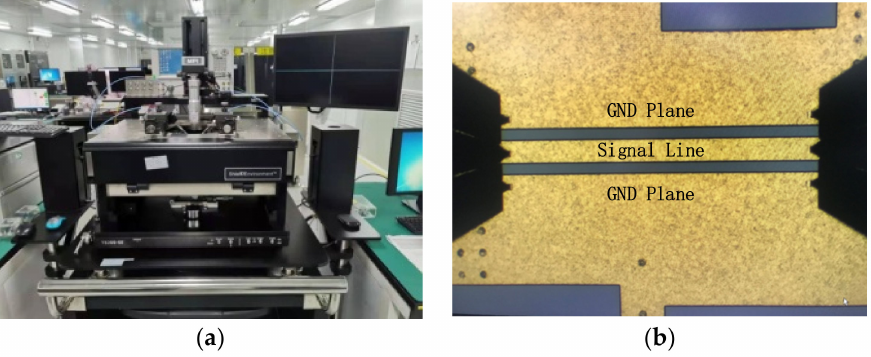
Figure 9. Photos of the PCM test setup and the DUT. ( a ) Probe station, ( b ) the